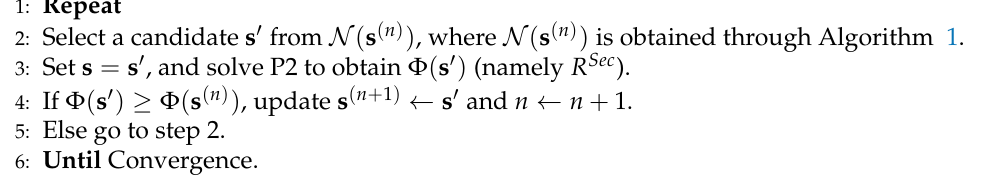
Algorithm 2 Proposed local optimal solution to P1